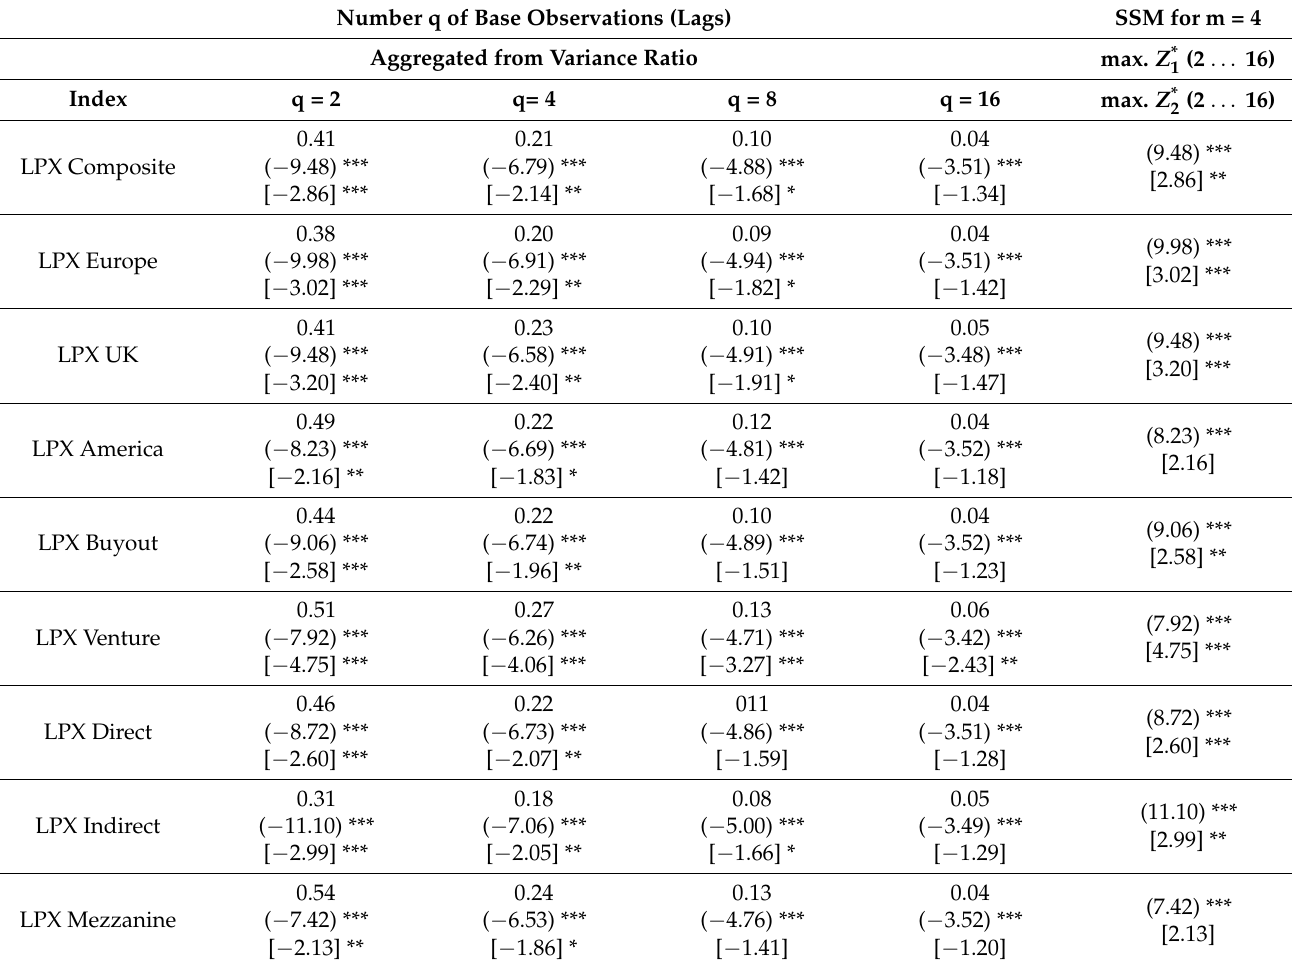
Table 5. Variance ratio estimates VR(q) and variance ratio test statistics for listed private equity index returns during the pre-crisis period (January 2004 to December